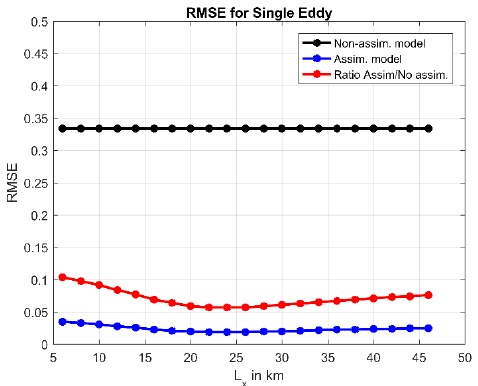
Figure 7. Dependence of RMSE for different eddy sizes: before data assimilation (black), after NDA assimilation (blue), the ratio of RMSE after and before data assimilation